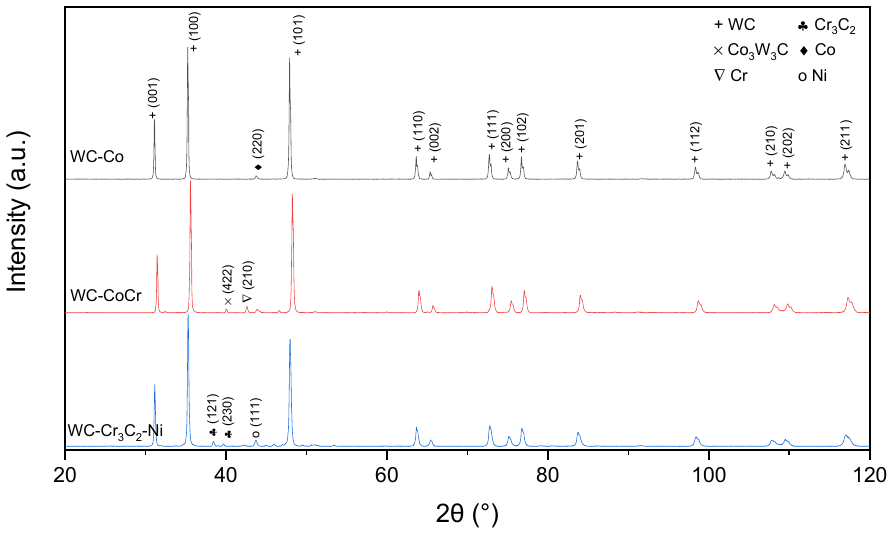
Figure 13. SAED diffraction analysis of sample C3; for the area marked on Figure 12a with letter A: WC with direction [210] ( a ); with the letter B: Cr 3 C 2 with direction [010] ( b ); with letter C: amorphous matrix ( c ).